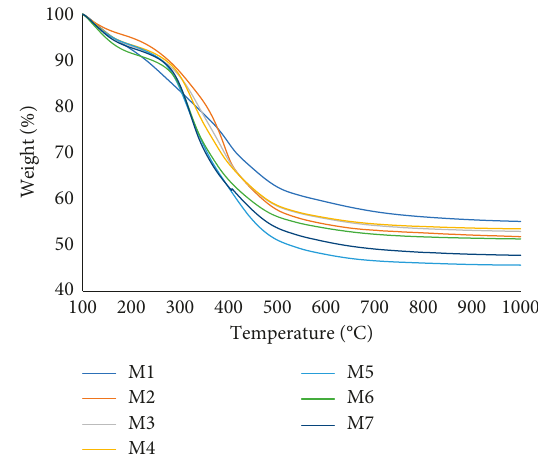
Figure 3: Thermogravimetric analysis of Mg/Al hydrotalcites.